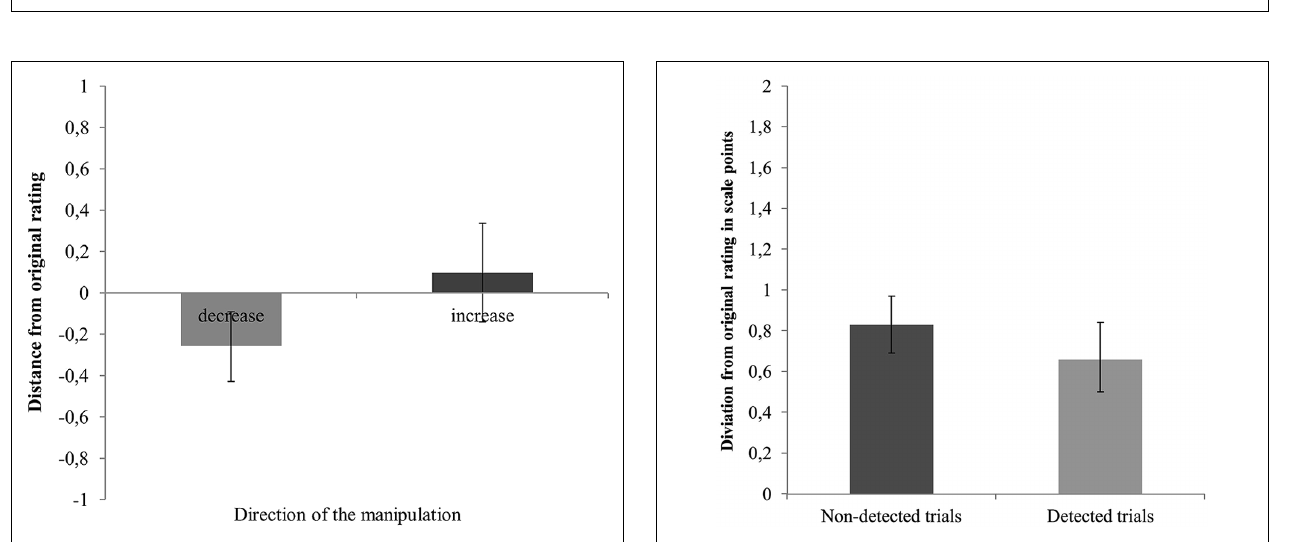
FIGURE 1 | Proportion of trials consistent with the original sympathy rating, the manipulated outcome, and neither of after the application of a conservative or lenient ( ± 1 scale point variance) criterion. Error bars represent 95% confidence intervals.